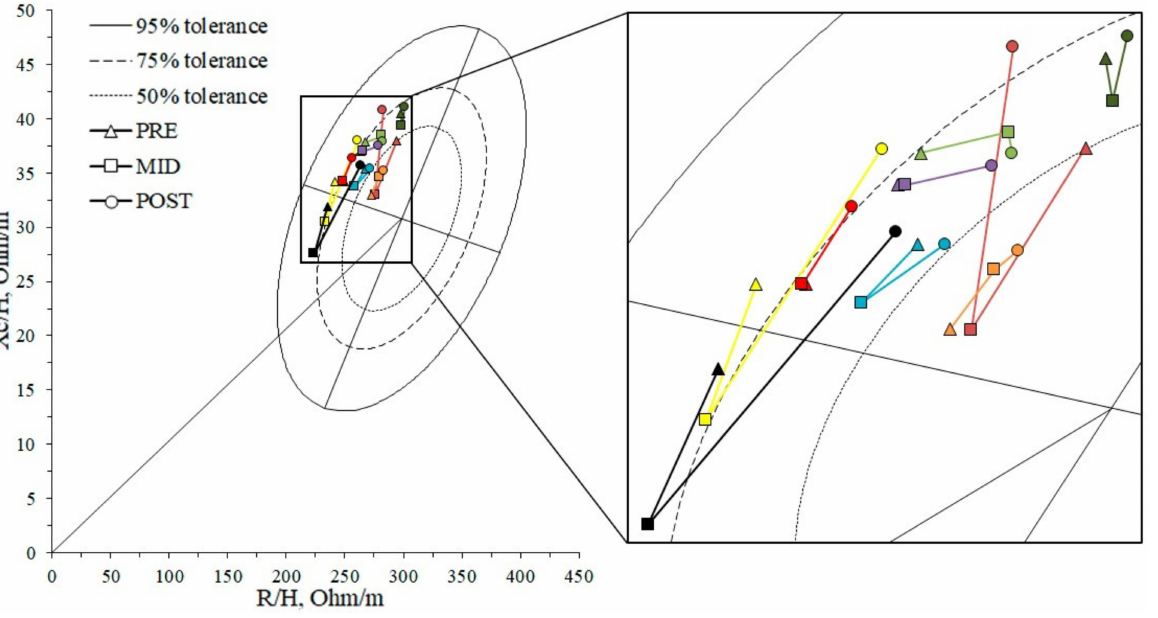
Figure 2. WB-BIVA Z-score point graph. Vector migration subjects over time were plotted with respect to the tolerance ellipse of the male adult Italian reference population [15]. R/H, height-adjusted resistance; Xc/H, height-adjusted